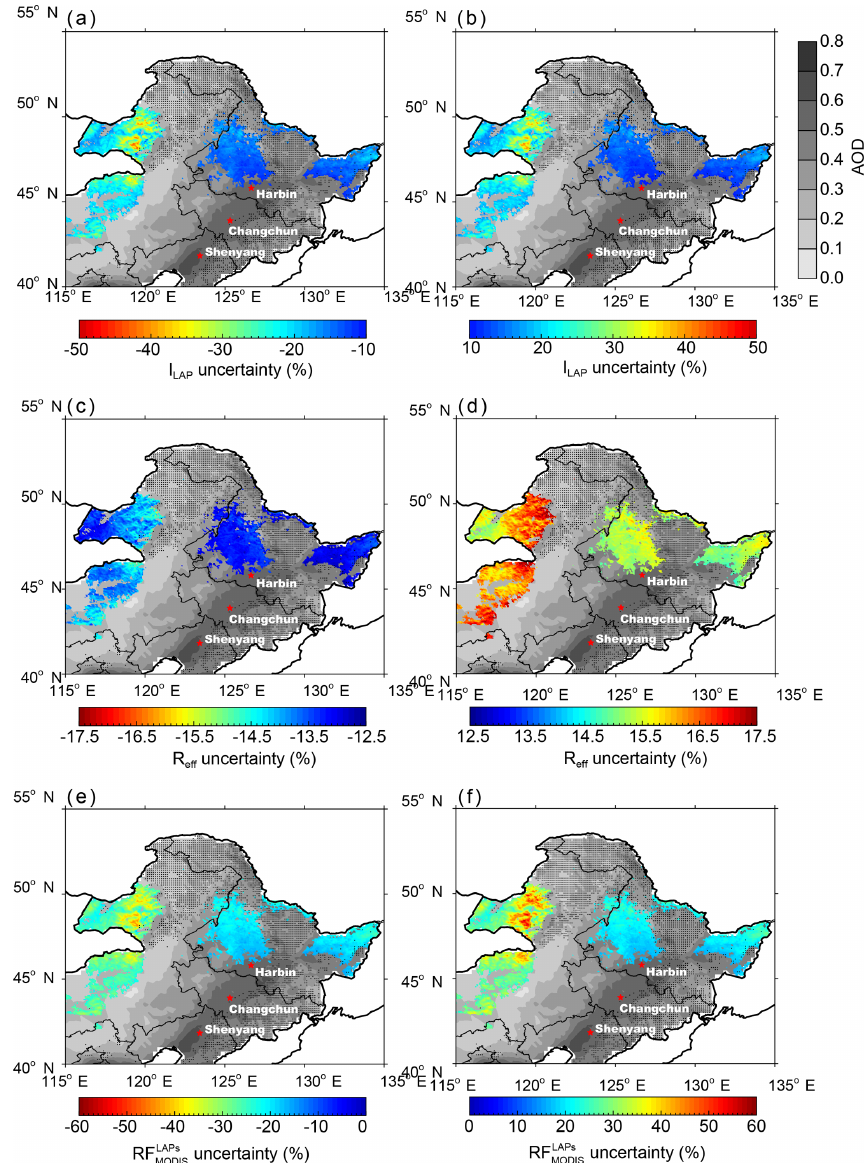
Figure 6. (a) Negative and (b) positive uncertainty of average I LAPs in NEC in January–February from 2003 to 2017. Panels (c) and (d) are similar to (a) and (b) , but for R eff . Panels (e) and (f) are similar to (a) and (b) , but for RF LAPs of MODIS AOD values. The dotted areas are covered by forests. The major cities in NEC are also shown in this